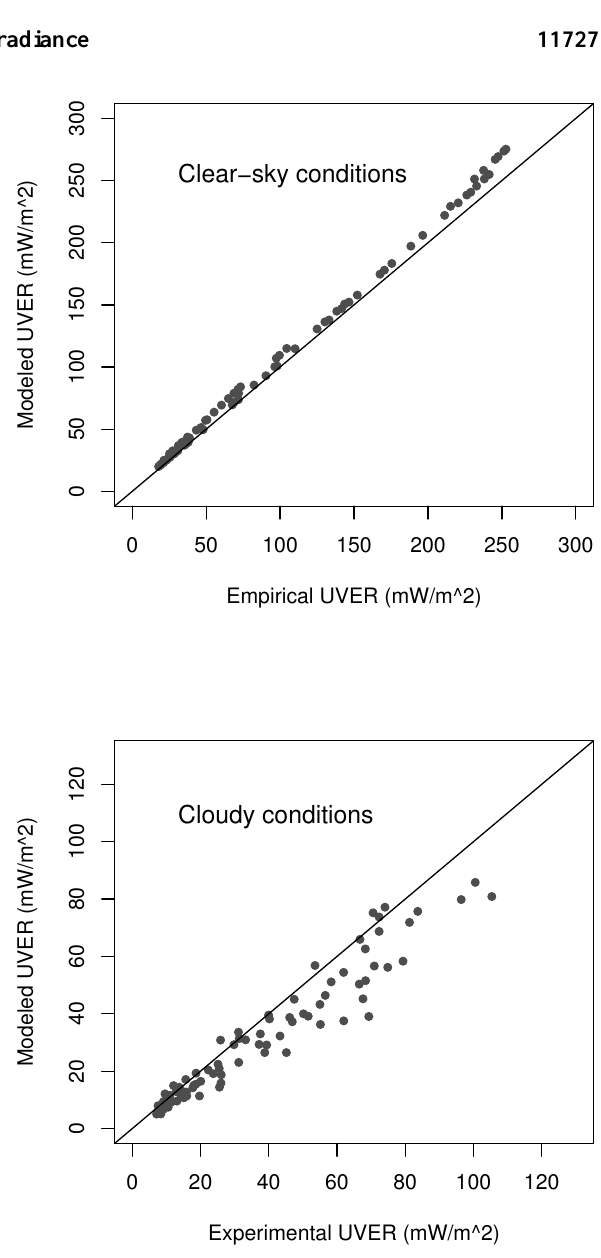
Fig. 2. Top: the empirical UVER against modeled values for the ideal clear-sky conditions corresponding to actual cloudy cases. Bottom: correlation between experimental and modeled UVER data under cloudy conditions. The solid black line is the zero bias line, unit